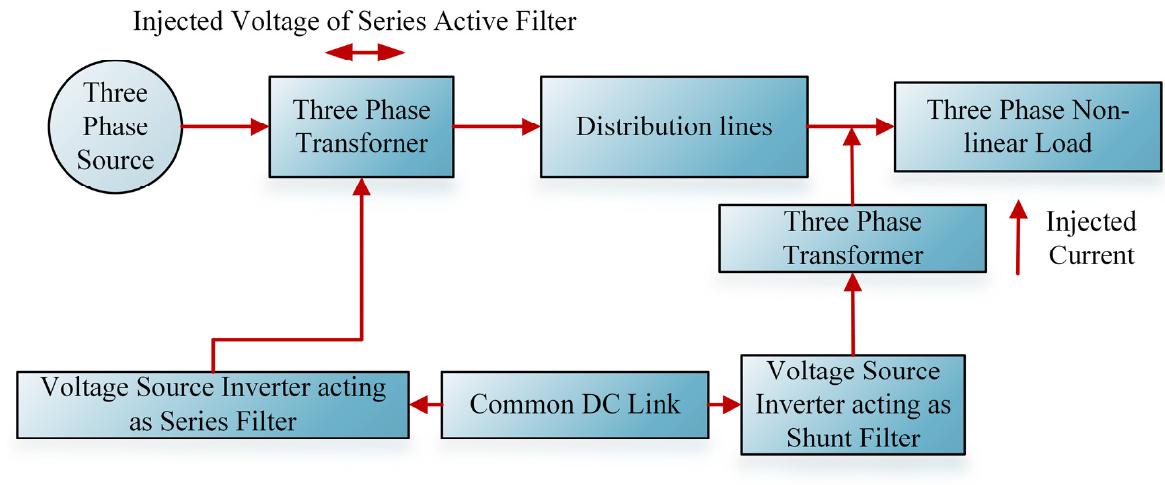
Figure 1. General block diagram representation of a power system with harmonic filters.